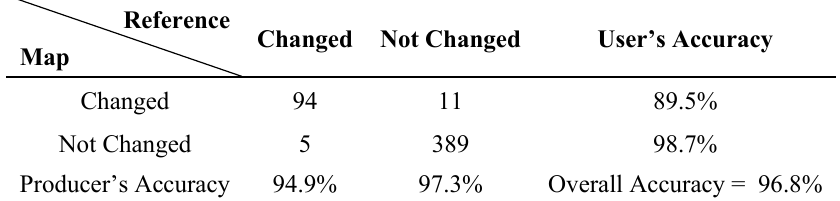
Table 5. Change detection error matrix, Maximum Likelihood classifier.